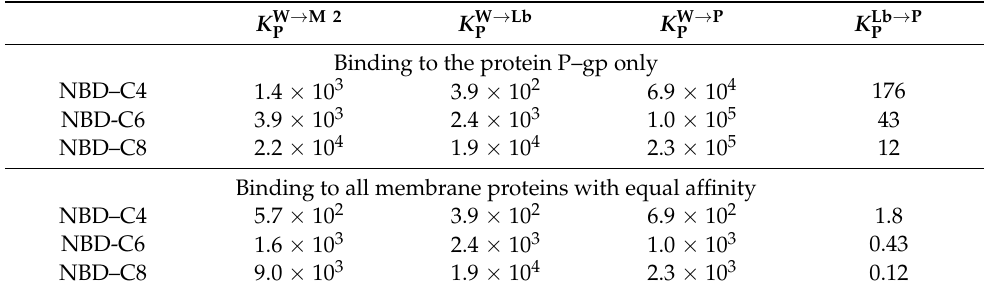
Table 2. Partition coefficient of the amphiphiles between the distinct media 1